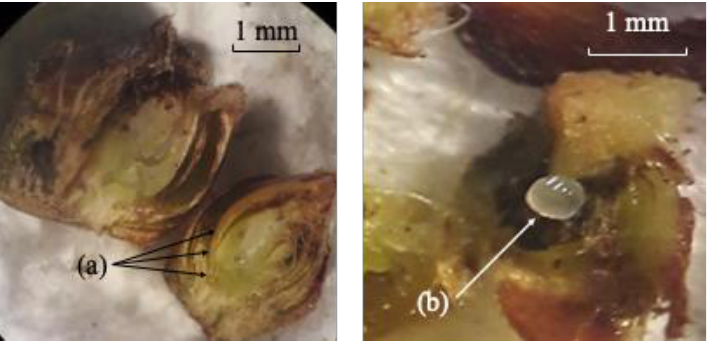
Figure 2. Larvae L1 ( a ) and ( b ) of D. kuriphilus inside chestnut buds, 2018 (binocular magnifying glass images). Table 2. D. kuriphilus infestation evaluated by the percentage of infested buds and average number of D. kuriphilus larvae per bud ± standard deviation in orchards P1 to P5 of Arcos de Valdevez (AVV)